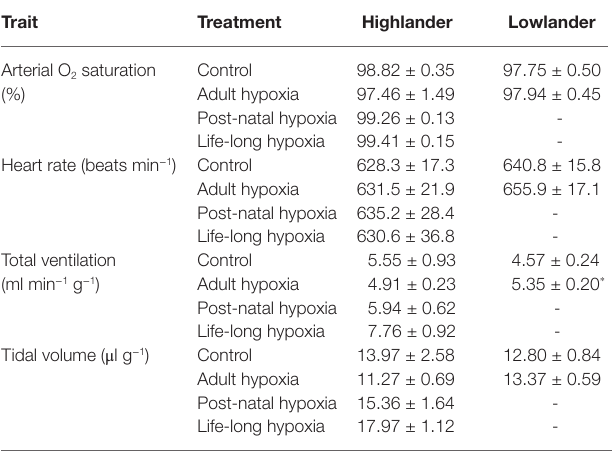
TABLE 1 | Measurements at thermogenic V mice and lowland white-footed mice exposed to hypoxia during different stages of development.